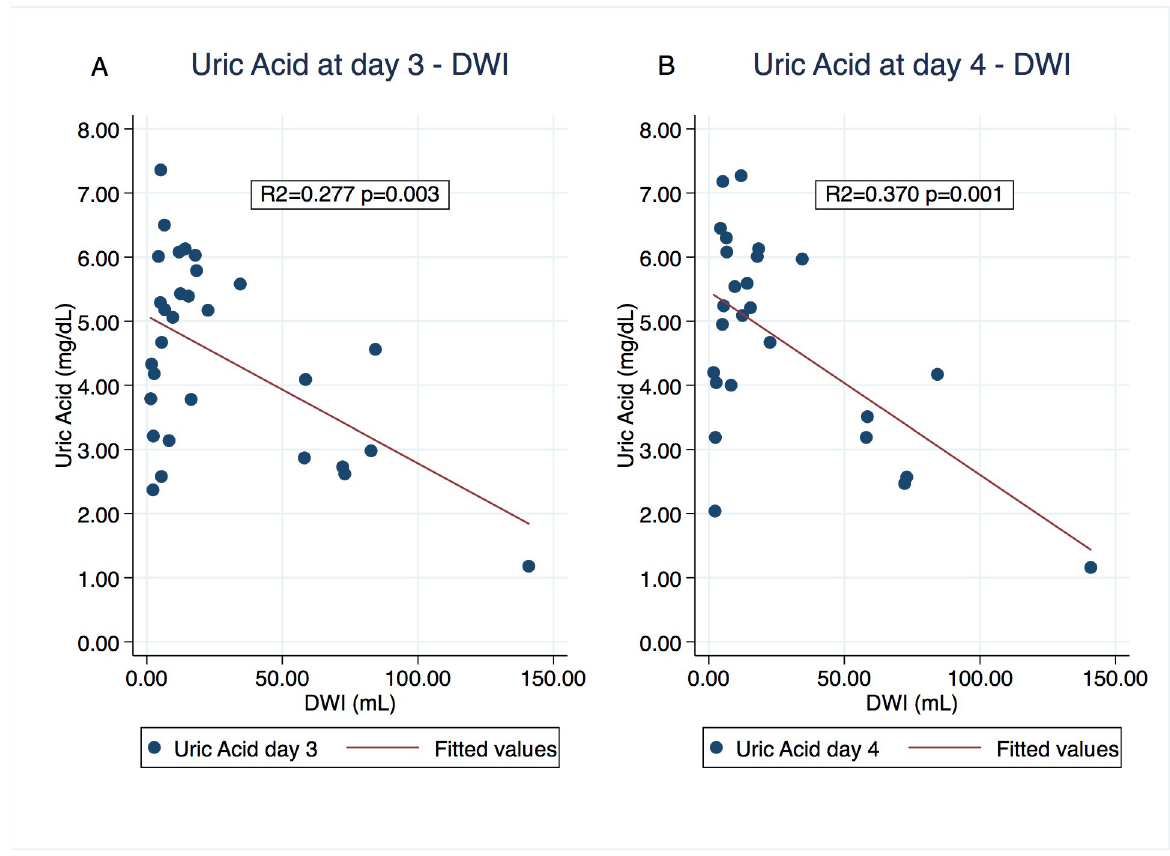
Fig 3. Linear regression of crude values of uric acid at day 3 (A) and day 4 (B) on DWI at diagnosis.